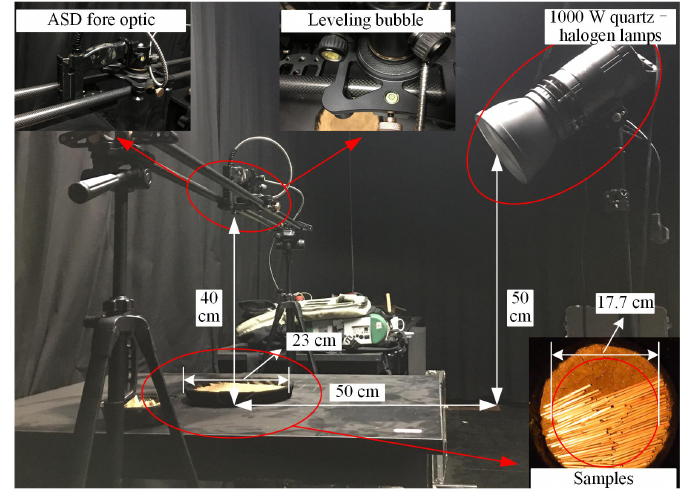
Figure 4. Experimental apparatus for measuring hyperspectral reflectance in the laboratory.